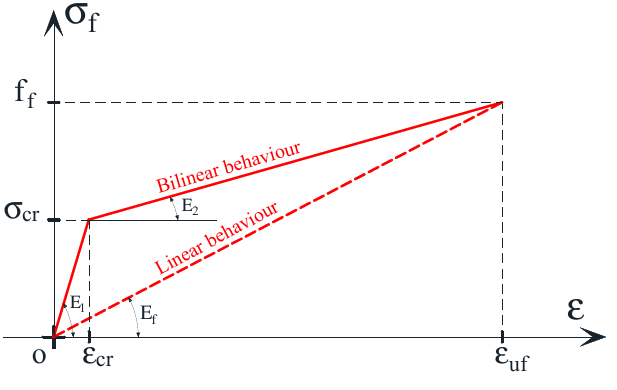
Figure 3. Different stress–strain constitutive relationships for composite systems in tension.